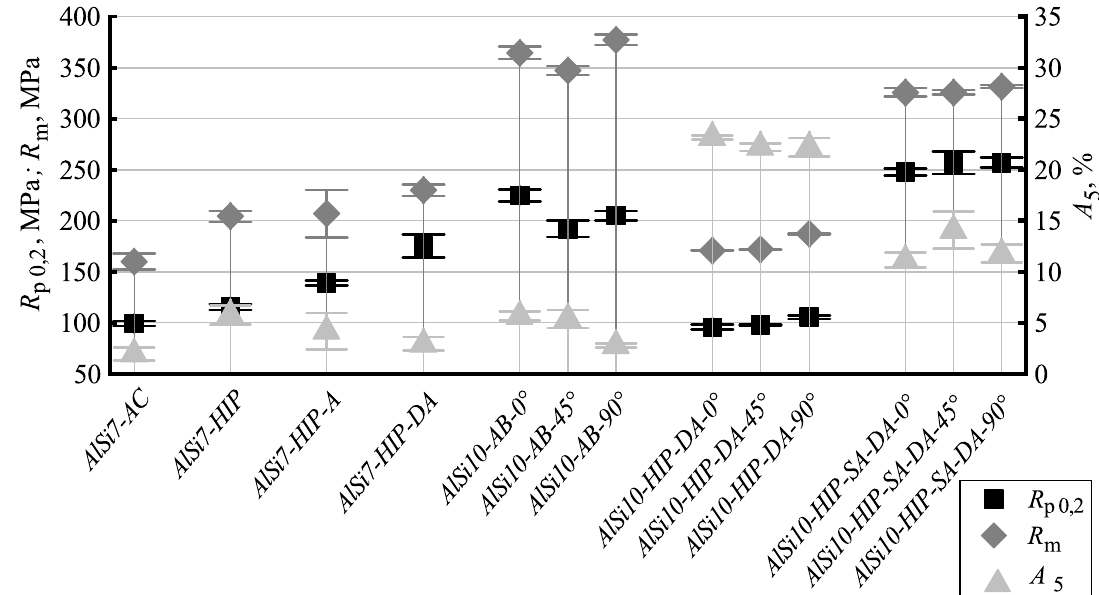
Figure 2. Tensile test results for all hot isostatically pressed and heat treated conditions. R p 0.2 is the yield strenght, R m is the ultimate tensile strength, A 5 is the elongation at fracture. Aluminum–Silicon AlSi7-AC is the as cast condition of the sand cast material. Aluminum–Silicon AlSi10-AB... denotes the as build condition of the L-PBF material. The labels Aluminum–Silicon ...-HIP, ...HIP-A, ...-HIP-DA, ...HIP-SA-DA indicate the utilized heat treatment which is explained in Section 2.1. The labels ...0 ◦ , ...45 ◦ and ...90 ◦ indicate the orientation of the samples to the substrate